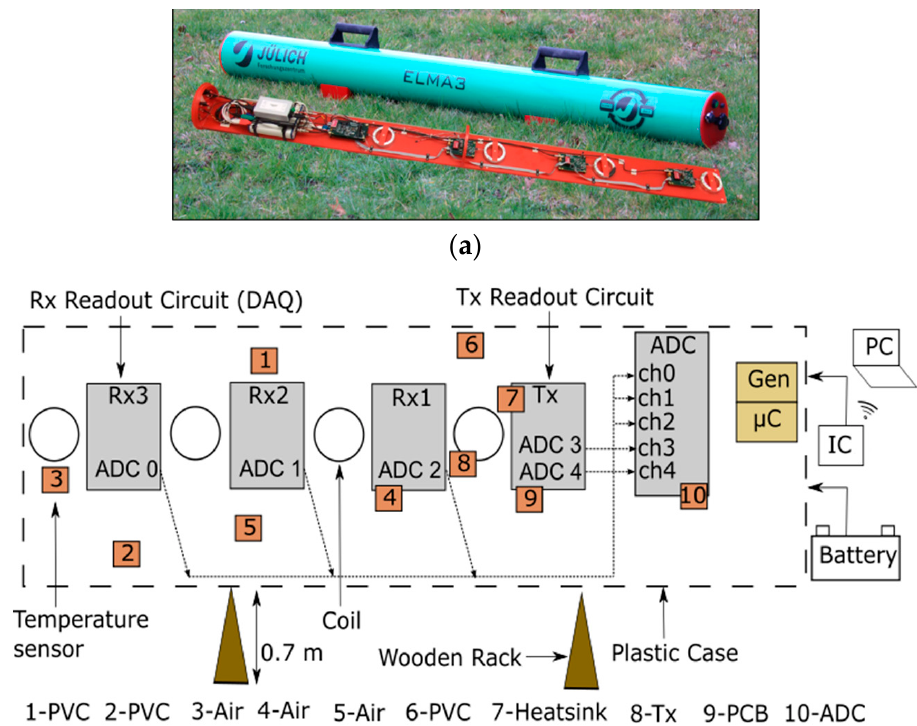
Figure 2. ( a ) Photo of the electromagnetic induction (EMI) instrument; ( b ) simplified representation of the EMI measurement setup. A polyvinyl chloride (PVC) pipe carries a transmitter (Tx) coil and three receiver (Rx) coils together with their readout circuits. An analog to digital converter (ADC), a generator unit (Gen), a microcontroller ( µ C) and an integrated computer (IC) all constitute the data acquisition unit (DAQ). The entire system is powered by an external battery and controlled remotely with the help of WLAN and a personal computer (PC). Sensor 9 measures the temperature of the printed circuit board (PCB); sensors 3, 4 and 5 monitor the air temperature inside the PVC tube; sensors 1, 2 and 6 measure the PVC temperature; sensor 8 measures the temperature at the Tx coil; sensor 7 measures the temperature of the heat sink, and sensor 10 measures the temperature of the ADC